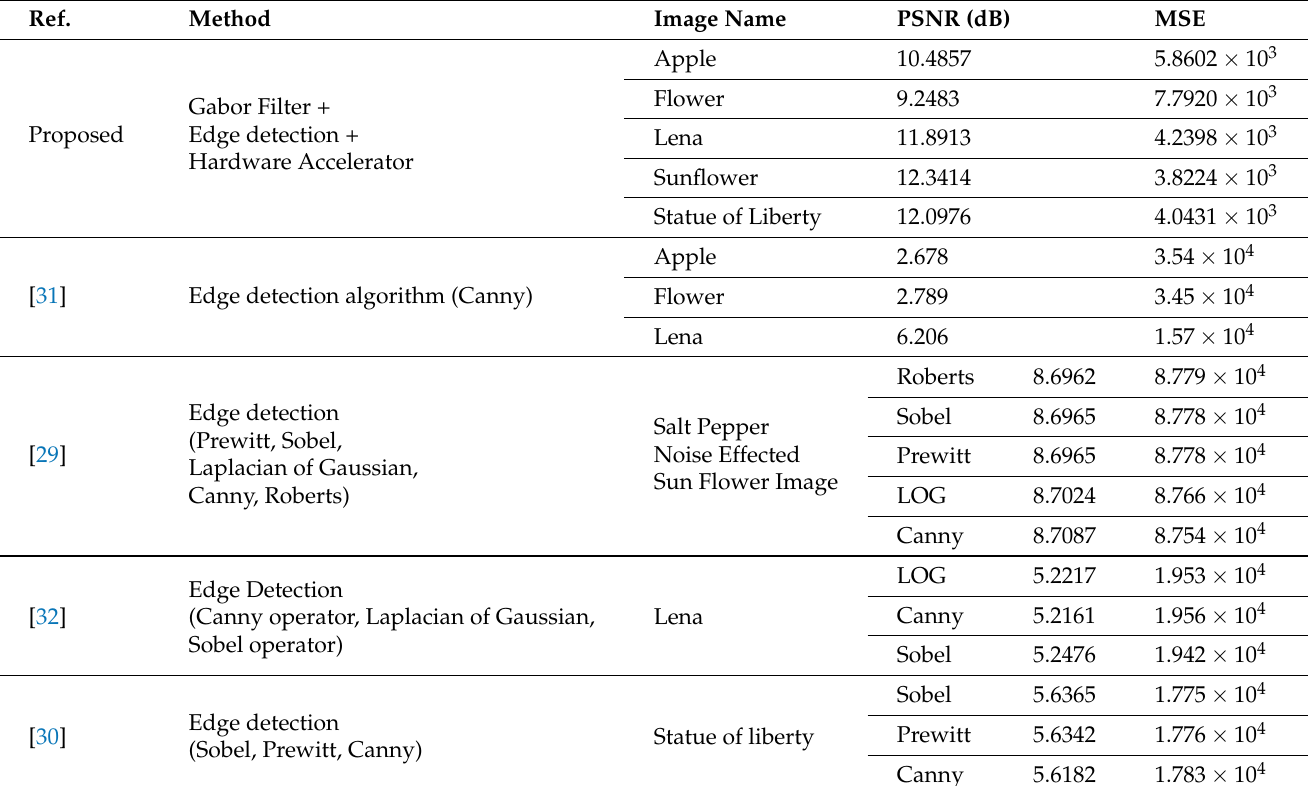
Table 2. Performance comparison with existing